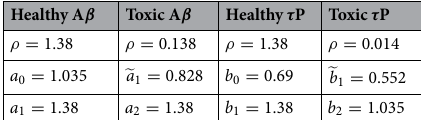
Table 2. General synthetic parameter